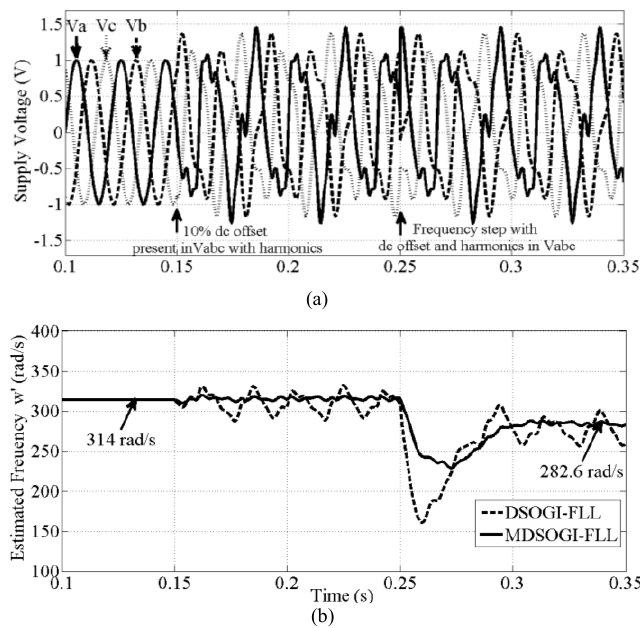
Performance when harmonics are present: (a) Three-phase grid voltage signals (b) Estimated frequency with DSOGI-FLL and MDSOGI-